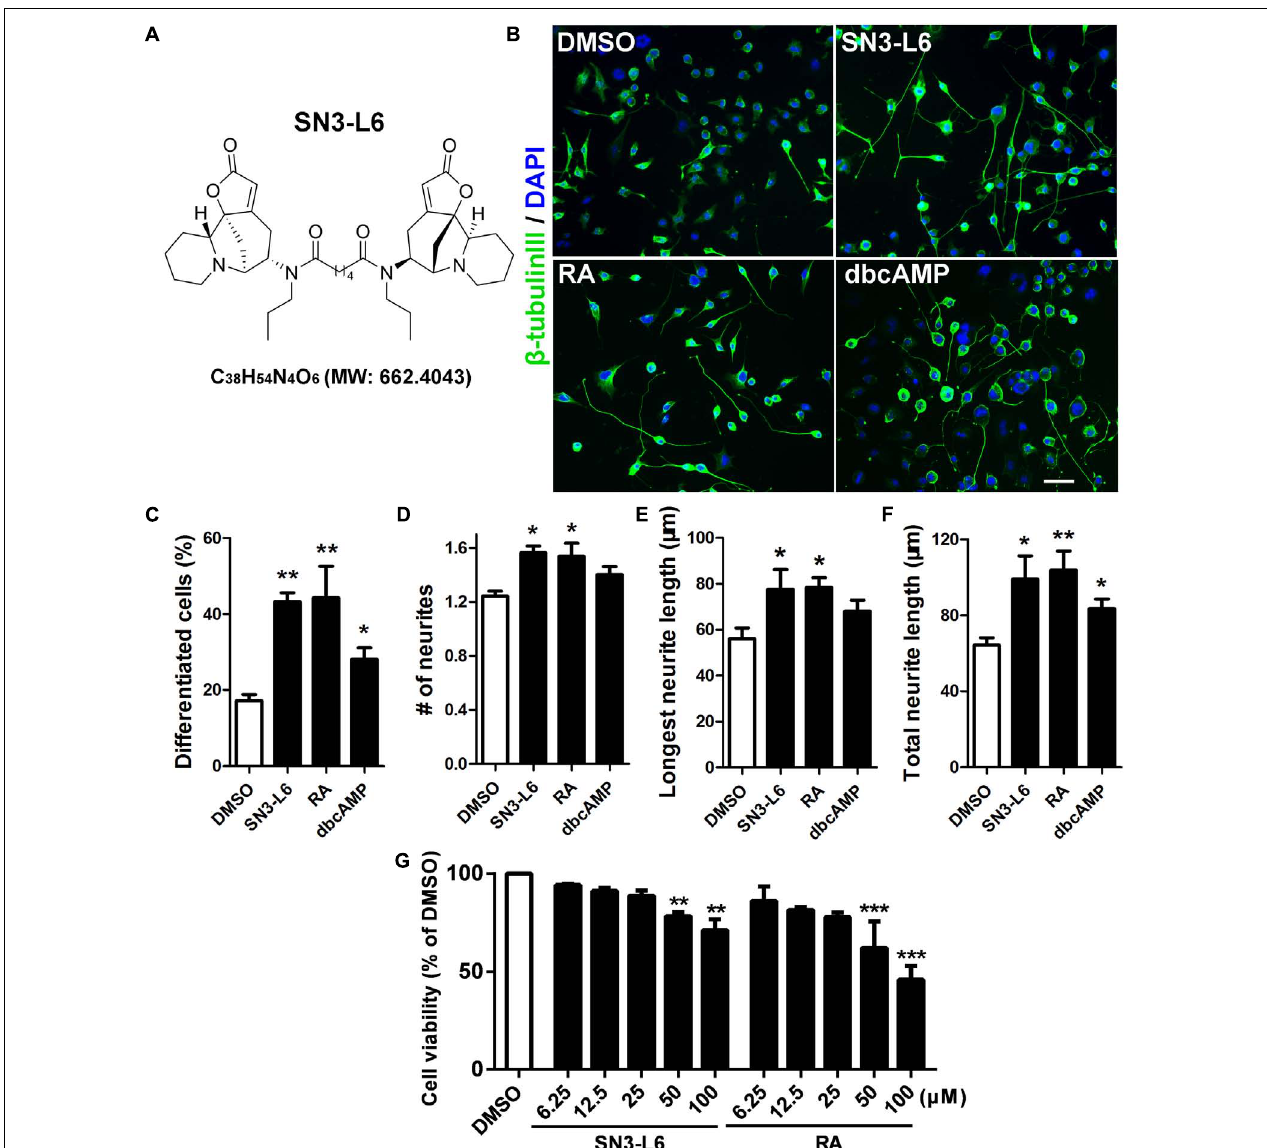
FIGURE 1 | SN3-L6 potently promotes differentiation and neurite outgrowth. (A) The chemical structure, the chemical formula and the exact mass of SN3-L6 are shown. (B) Representative images of Neuro-2a cells after treatment with SN3-L6 (25 µ M), RA (10 µ M), or dibutyl cyclic AMP (dbcAMP) (0.5 mM) for 48 h. Scale bar, 50 µ m. Neurites and nuclei were visualized using β -tubulin III antibody (green) and 49,6-diamidino-2-phenylindole (DAPI) (blue), respectively. Differentiation rate (% of cells that possess at least one process longer than 40 µ m; C ), neurite number (D) , longest neurite length (E) , and total neurite length (F) were quantified. ∗ P < 0.05, ∗∗ P < 0.01, indicated compound vs. DMSO. (G) Neuro-2a cells were treated with SN3-L6 or RA in a concentration gradient (6.25, 12.5, 25, 50, and 100 µ M) for 48 h. Cell viability was tested using MTT assay. ∗∗ P < 0.01, ∗∗∗ P < 0.001, SN3-L6 or retinoic acid (RA) vs. DMSO. All data shown in this figure are presented